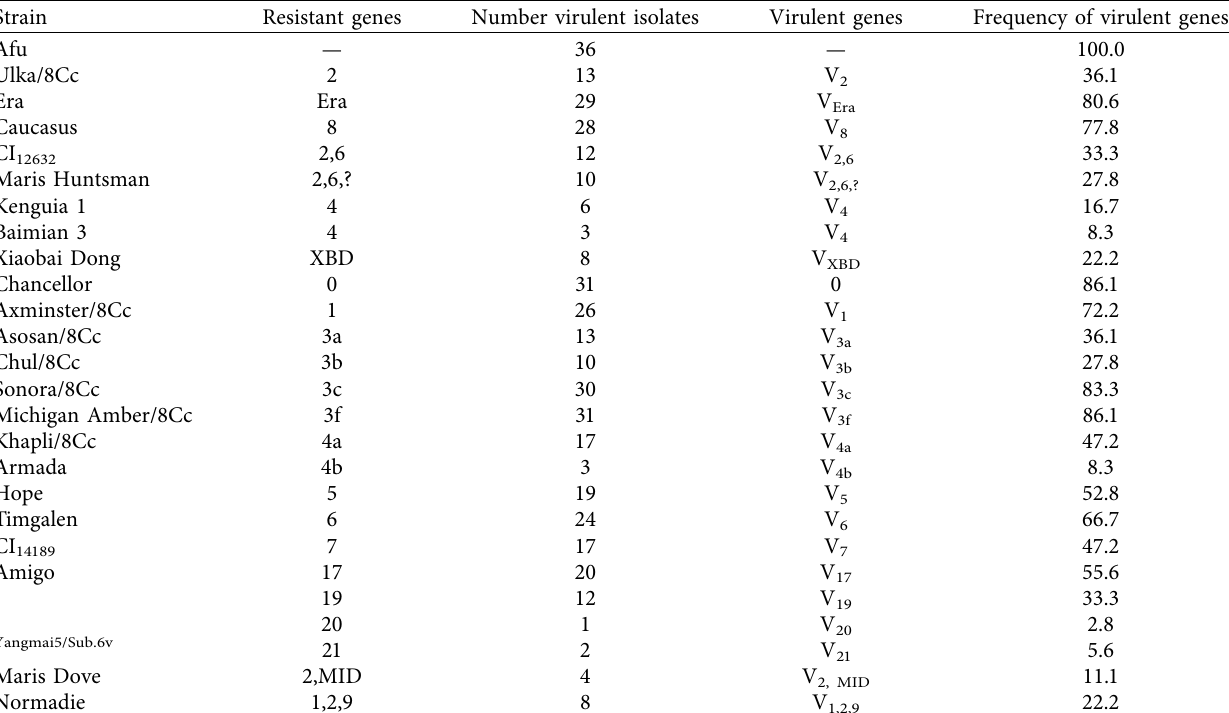
Table 2: Group virulence frequency of Blumeria graminis f.sp. tritici in central Hebei province, 2019.